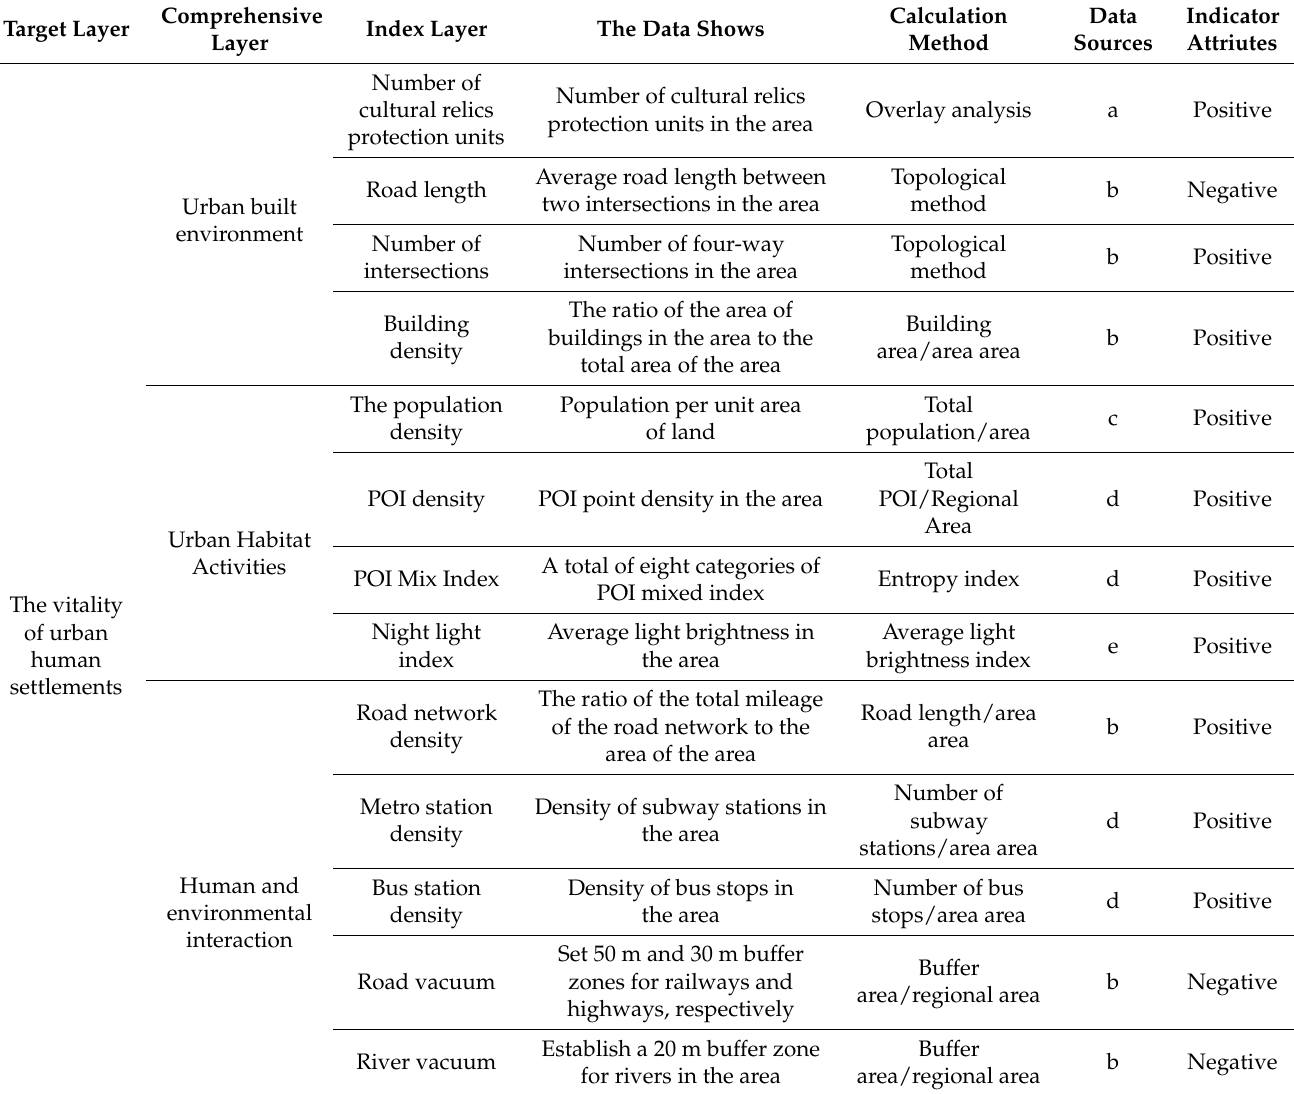
Table 1. Evaluation index system of urban human settlements